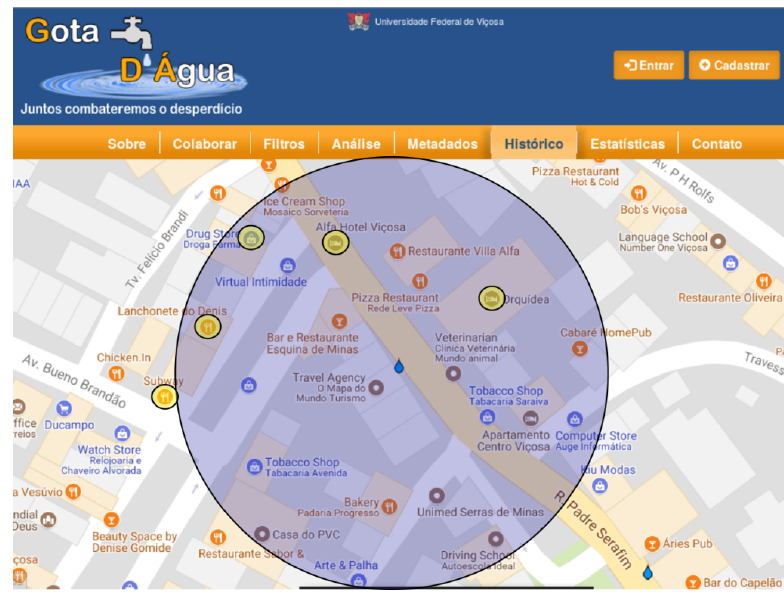
Figure 3. Example of a contribution semantically enriched by the proposed algorithm using Google Maps in the Gota D’Água system interface.